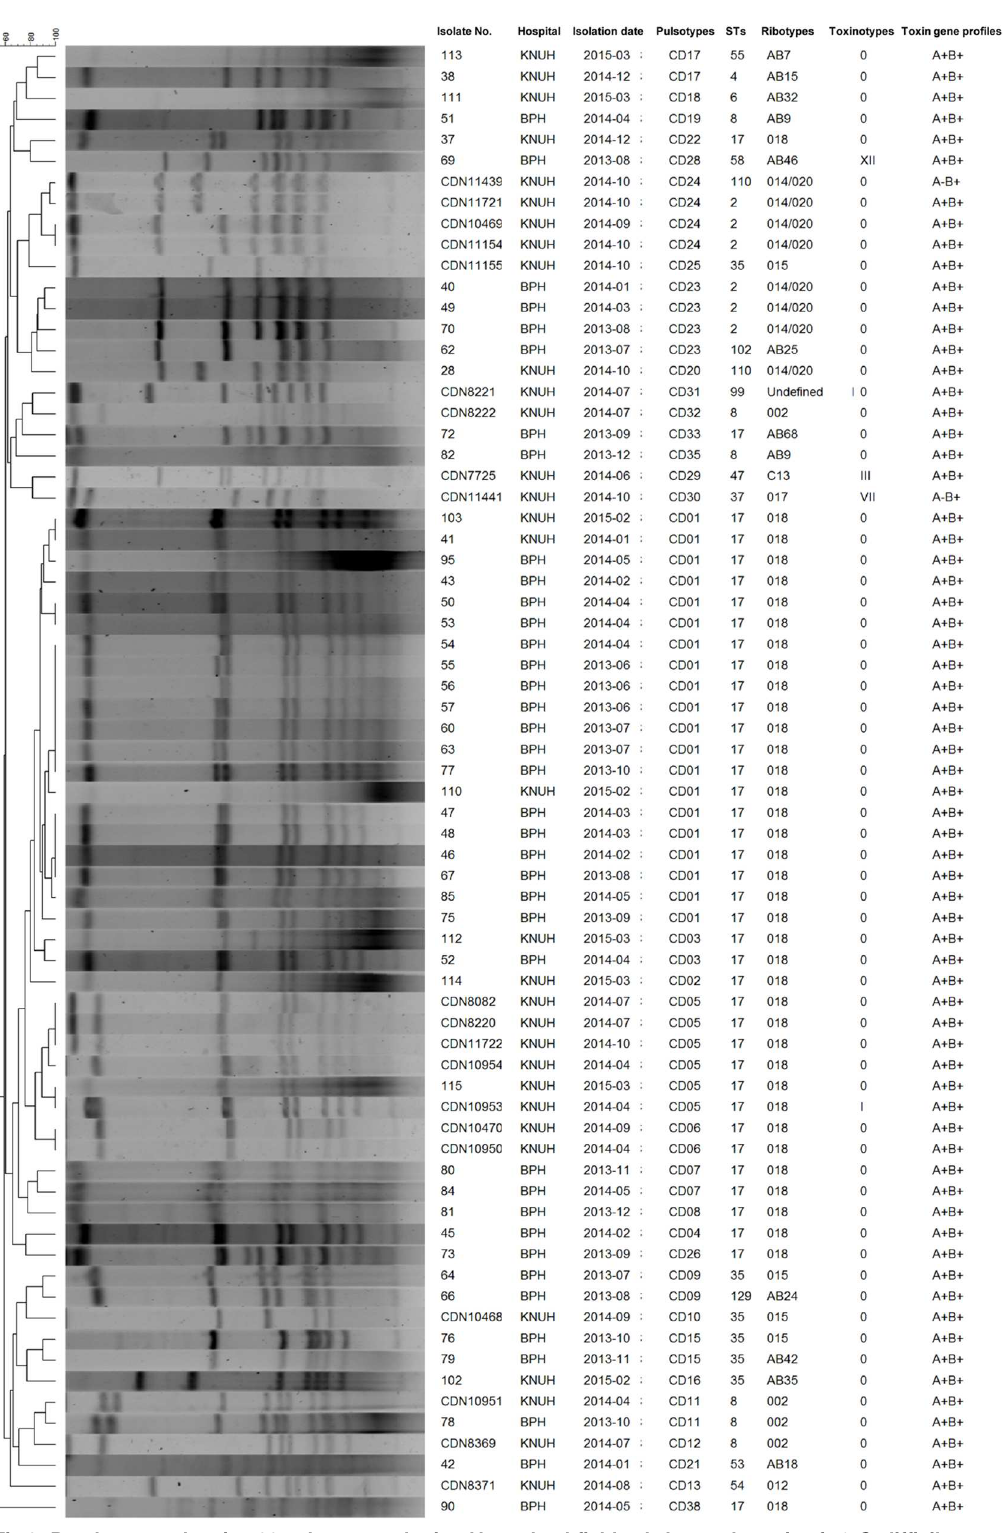
PLOS ONE | https://doi.org/10.1371/journal.pone.0174716 March 29,